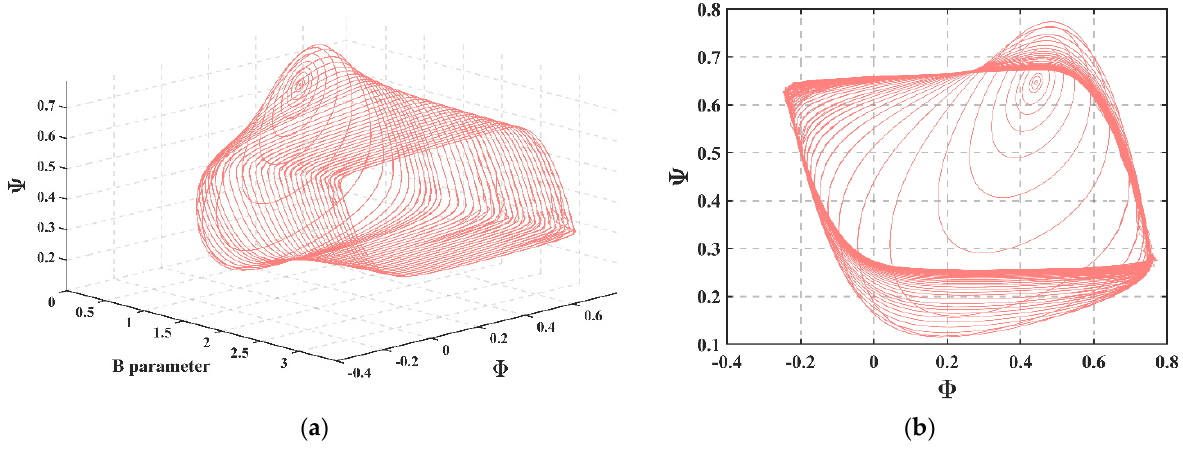
Figure 6. The variation of the limit cycle with B parameter: ( a ) Mass flow instability coefficient; ( b ) Pressure rise instability coefficient.